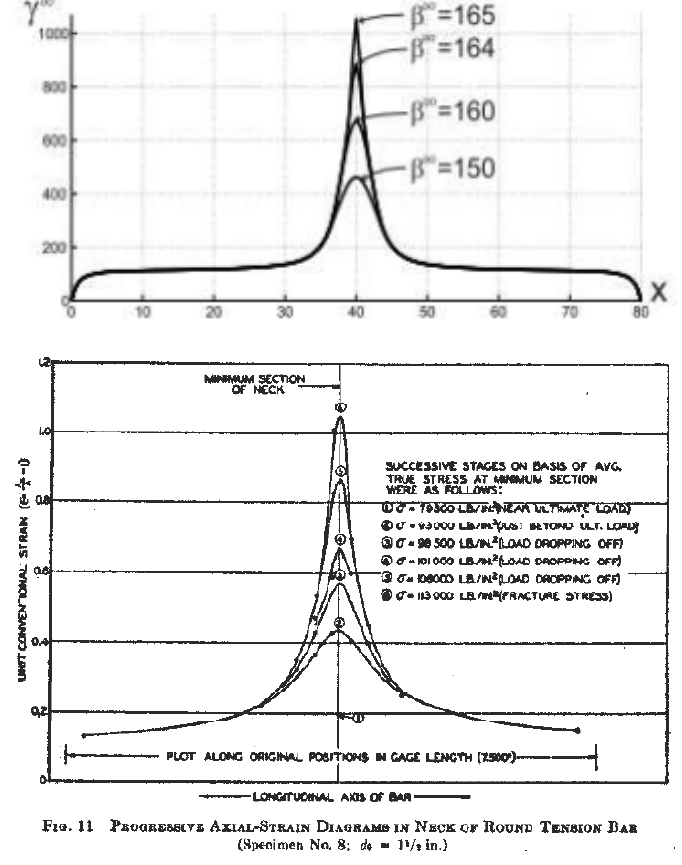
Figure 5: The inelastic deformation  as a function of x , for different values of the total elongation  . The first diagram shows the results of the numerical simulations, and the second shows the experimental measurements reported in